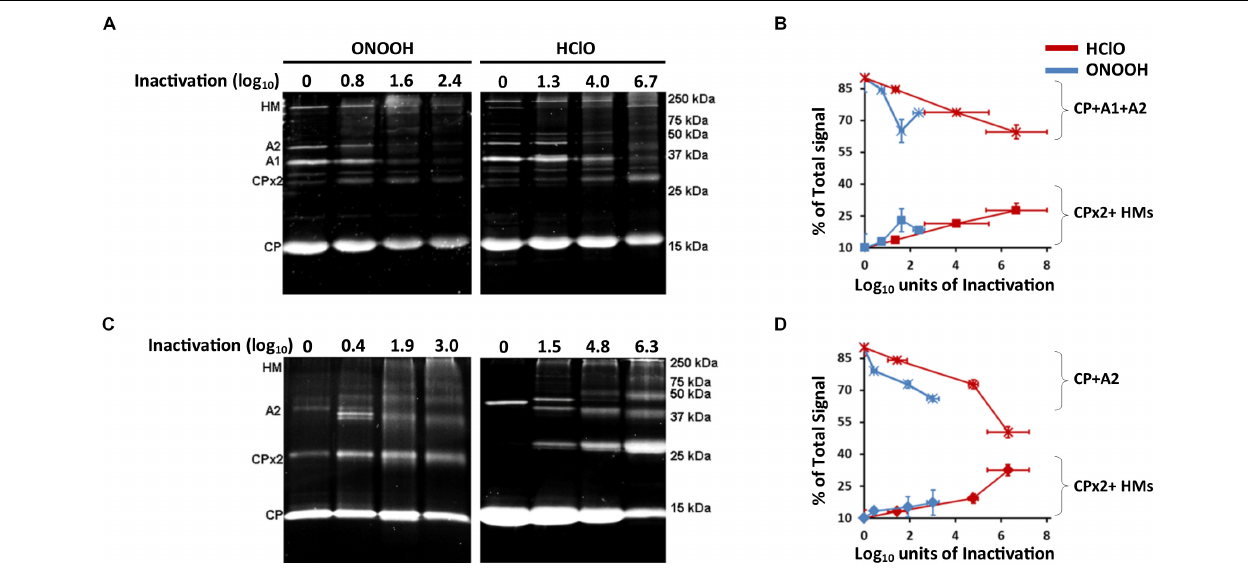
FIGURE 5 | HClO and ONOOH cross-link Q β and MS2 capsid proteins. (A) Images of SDS-PAGE stained with Oriole showing the capsid proteins masses of Q β phage when inactivated or not by ONOOH- in the left panel and HClO- in the right panel, the levels of inactivation are indicated on top the gels. Capsid protein names are showed on the left side of the gels, markers of size are indicated on the right side of the gels. (B) Curves showing the evolution of the constitution of Q β phage capsid proteins by the treatment of HClO- and ONOOH- induced inactivation as observed by SDS-PAGE; the star marker is for the added percent intensities of single proteins CP + A1 + A2, the square marker is for the added percent intensities of cross-linked proteins CP dimer (CPx2) + CP-A1-A2 multimer (HMs). (C) Image of SDS-PAGE stained with Oriole showing the capsid proteins masses of MS2 phage when inactivated or not by ONOOH- in the left panel and HClO- in the right panel, the levels of inactivation are indicated on top the gels. Capsid protein names are showed on the left side of the gels, markers of size are indicated on the right side of the gels. (D) Curves showing the evolution of the constitution of MS2 phage capsid proteins constitution by the treatment of HClO- and ONOOH- induced inactivation as observed by SDS-PAGE; the star marker is for the added percent intensities of single proteins CP + A2 proteins, the square marker is for the added percent intensities of cross-linked proteins CP dimer (CPx2) + CP-A2 multimer (HMs). In (A–D) , each result is representative of at least three independent experiments carried out on separate days. Error bars stand for SEM.